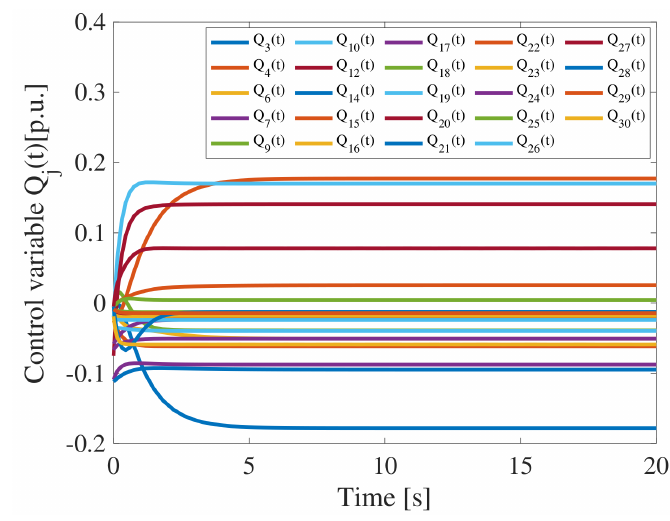
Figure 5. Time history of the reactive power Q j ( t ) [ p . u . ] for j ∈ N c .